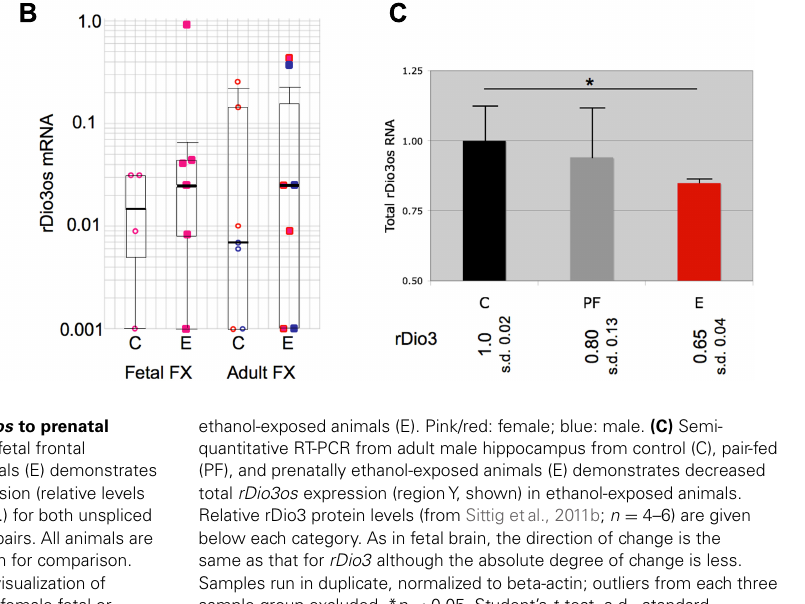
ethanol-exposed animals (E). Pink/red: female; blue: male. (C) Semi- quantitative RT-PCR from adult male hippocampus from control (C), pair-fed (PF), and prenatally ethanol-exposed animals (E) demonstrates decreased total rDio3os expression (regionY, shown) in ethanol-exposed animals. Relative rDio3 protein levels (from Sittig etal., 2011b; n = 4–6) are given below each category. As in fetal brain, the direction of change is the same as that for rDio3 although the absolute degree of change is less. Samples run in duplicate, normalized to beta-actin; outliers from each three sample group excluded. * p < 0.05, Student’s t -test. s.d., standard